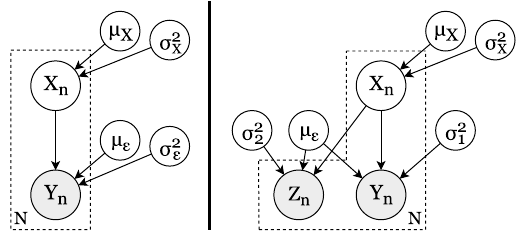
Fig. 2 The setup in plate notation. X n represent the true, unobserved values of the items to be ranked. (L) Y n represents the observed values under some estimation noise level 𝜎 2 𝜖 . (R) When we change the noise level from 𝜎 2 1 to 𝜎 2 2 , we obtain two sets of observed values, Y n and Z n , for each noise